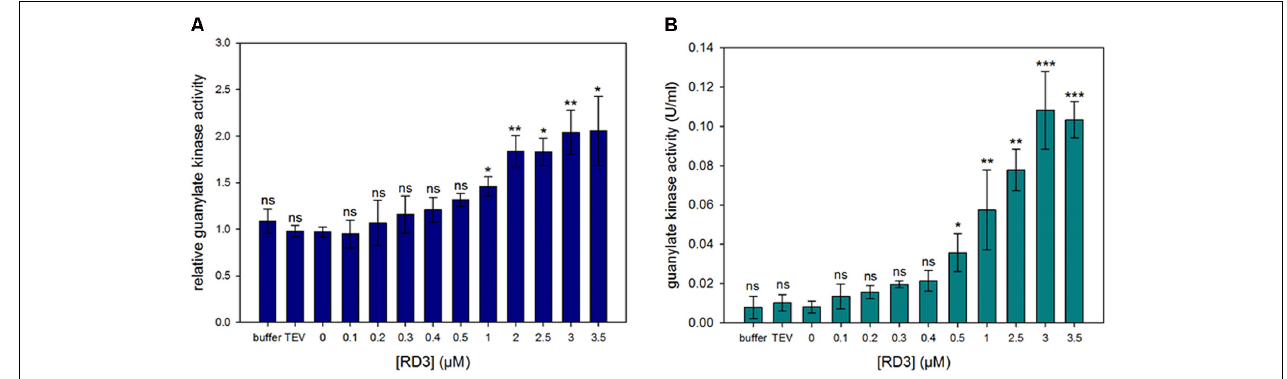
FIGURE 2 | Guanylate kinase activity assay. Activity determination of GUK in a spectrophotometric assay. The 5 (cid:48) -GMP to GDP conversion is coupled to NADH oxidation and the decrease in absorption is measured at 340 nm. Effect of varying RD3 concentrations on enzyme activity was tested. GUK in a soluble extract from bovine ROS (A) and GUK from porcine brain (B) were used. Normalization value 1.0 in (A) corresponds to GUK activities in the absence of RD3, which were between 0.025 and 0.042 U/mg rhodopsin. The experiment was repeated independently three times with two to three replicates for each sample yielding similar results. Statistical analysis was performed using GraphPad Prism V5.01 (GraphPad Prism Inc.). The data failed the Kolmogorov–Smirnov normality test. Therefore, the Kruskal-Wallis one-way ANOVA with post hoc tests (Dunn’s Multiple Comparison) were applied to determine if groups were significantly different from each other (significance levels are ns = p > 0.05, ∗ p ≤ 0.05, ∗∗ p ≤ 0.01, ∗∗∗ p ≤